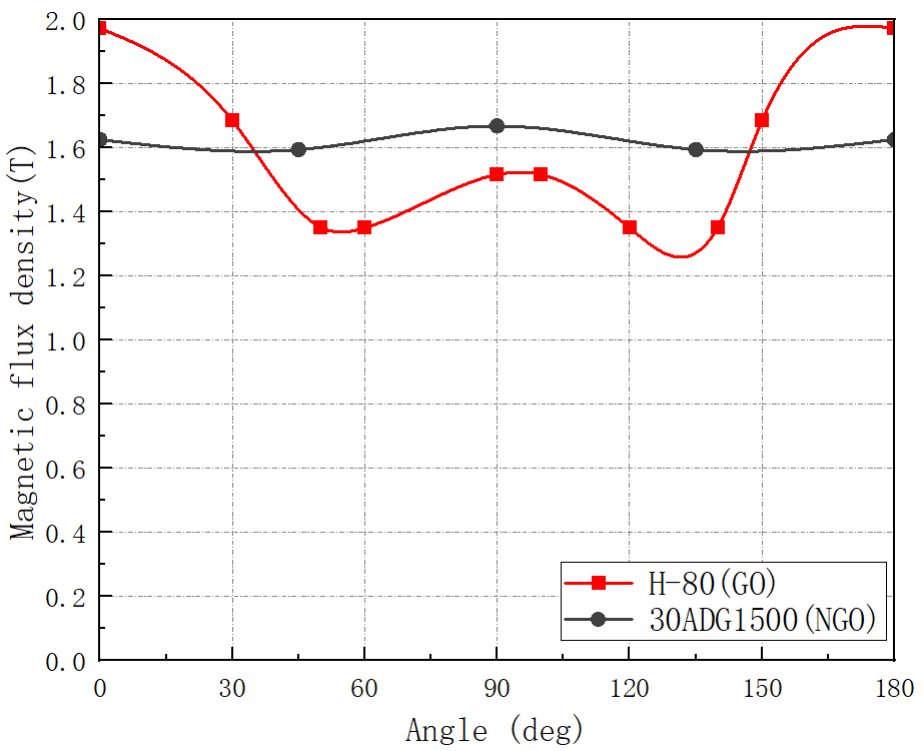
Figure 11. Comparison of saturation flux density of oriented and non-grain-oriented silicon steel with different magnetization angles.